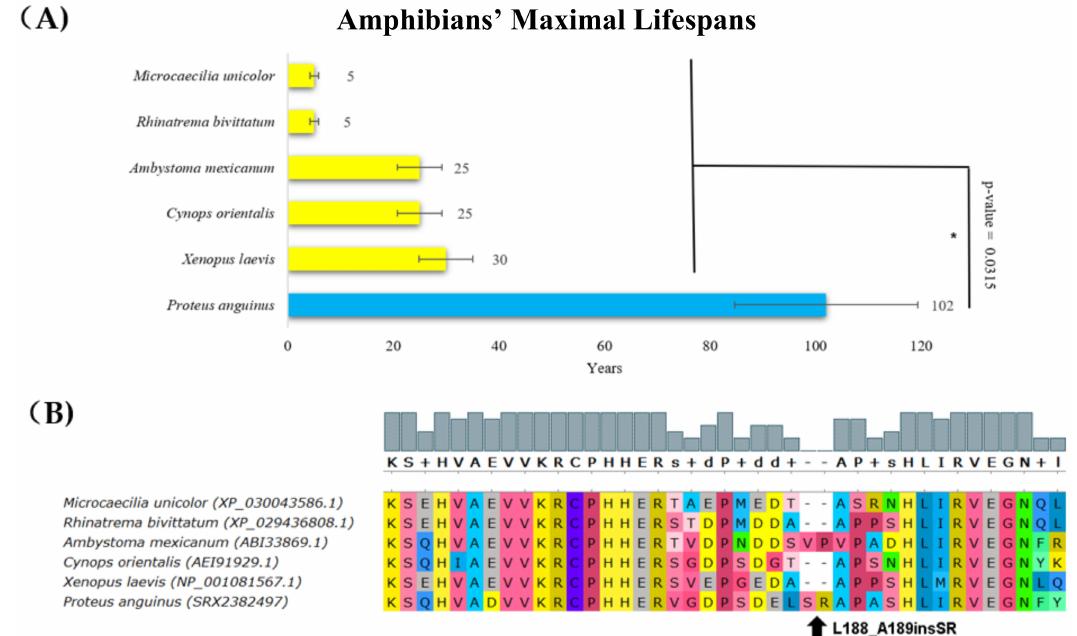
Figure 2. Lifespan of species in amphibians and the corresponding p53 sequence changes. ( A ) Comparison of amphib- ians’ maximal lifespans in years. The olm’s ( Proteus anguinus ’s) maximal lifespan was more than three times higher than the maximal lifespan of other amphibians (Wilcoxon one-sided signed-rank test, * p -value < 0.05). ( B ) Multiple protein alignments of the p53 dimerization region. The olm ( Proteus anguinus ) had an insertion that is two amino acid residues long following amino acid residue 188 (related to human p53 canonical sequence). The sequence of the p53 homolog from Proteus anguinus was determined using transcriptomic data from the SRA Archive (SRX2382497). The methods and color schemes are the same as in Figure